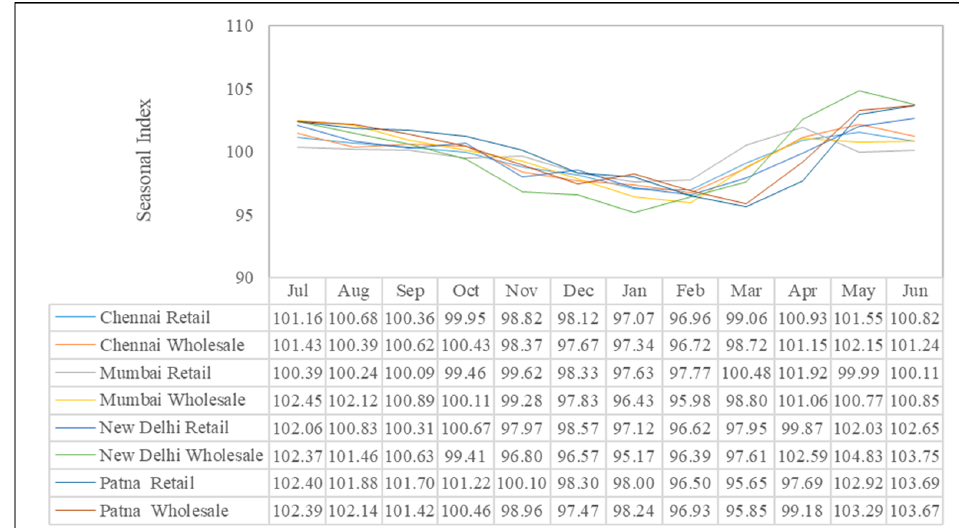
Figure 4. Seasonal price variations in wheat markets .